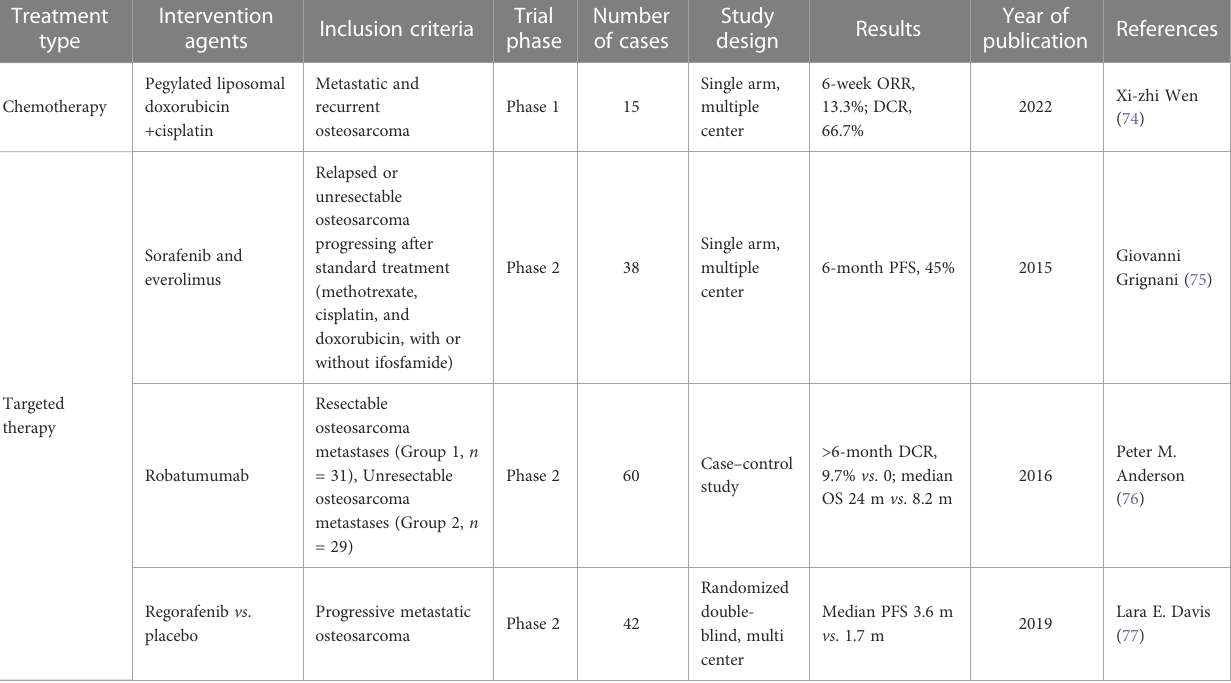
TABLE 1 Results of recent clinical trials involving patients with advanced or metastatic osteosarcoma.